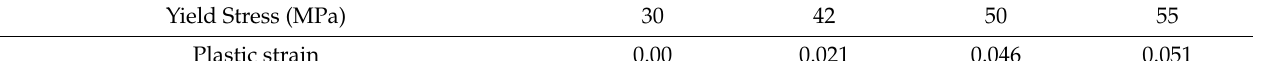
Table 2. Variation in plastic strain with yield stress.